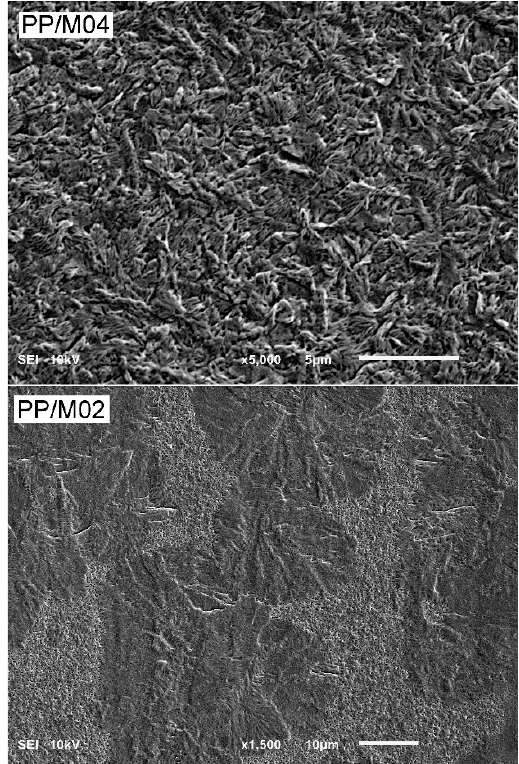
Figure 6. SEM micrographs of PP/M04 and PP/M02 after nonisothermal crystallization (protocol I) under 300 MPa, and etching.